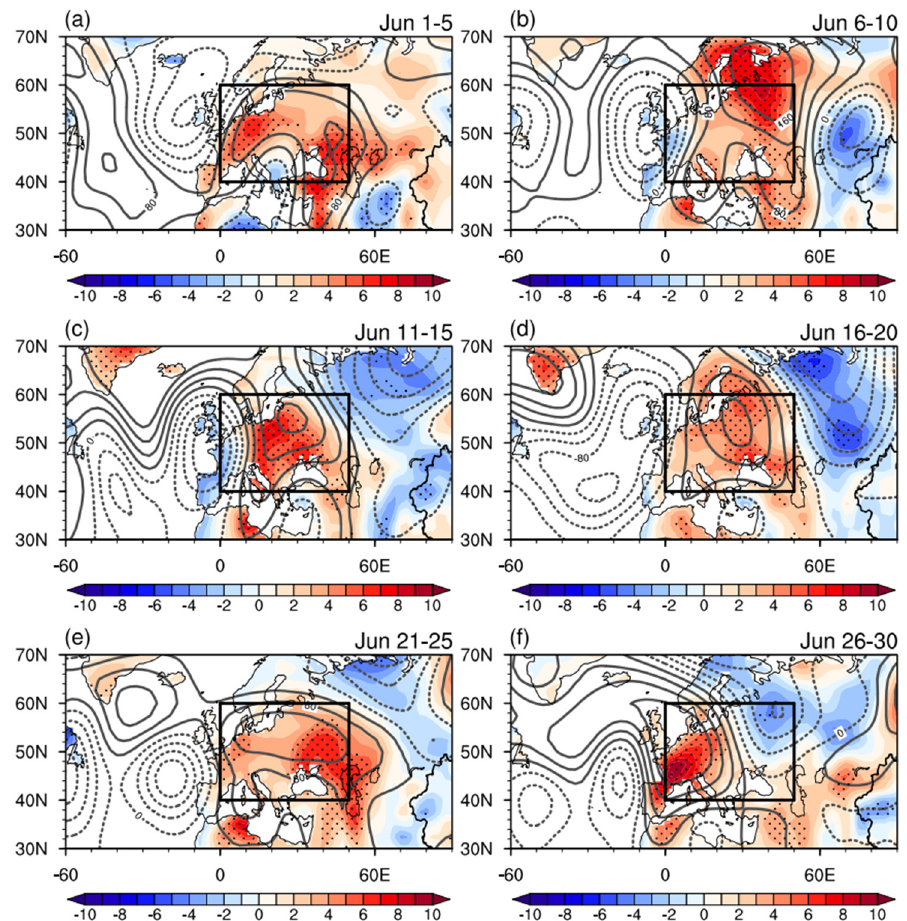
Figure 7. Pentad evolution of SAT (shadings, unit: ◦ C) and 500-hPa geopotential height (contours, unit: gpm) in June of 2019 relative to 1948–2019. The interval of contours is 40 gpm. Negative anomalies of 500-hPa geopotential height are denoted by the dashed contours. Stippling regions represent SAT anomalies exceeding one standard deviation from 1948 to 2019. ( a – f ) respectively illustrate SAT and 500-hPa geopotential height anomalies during the first pentad to the sixth pentad in June of 2019.